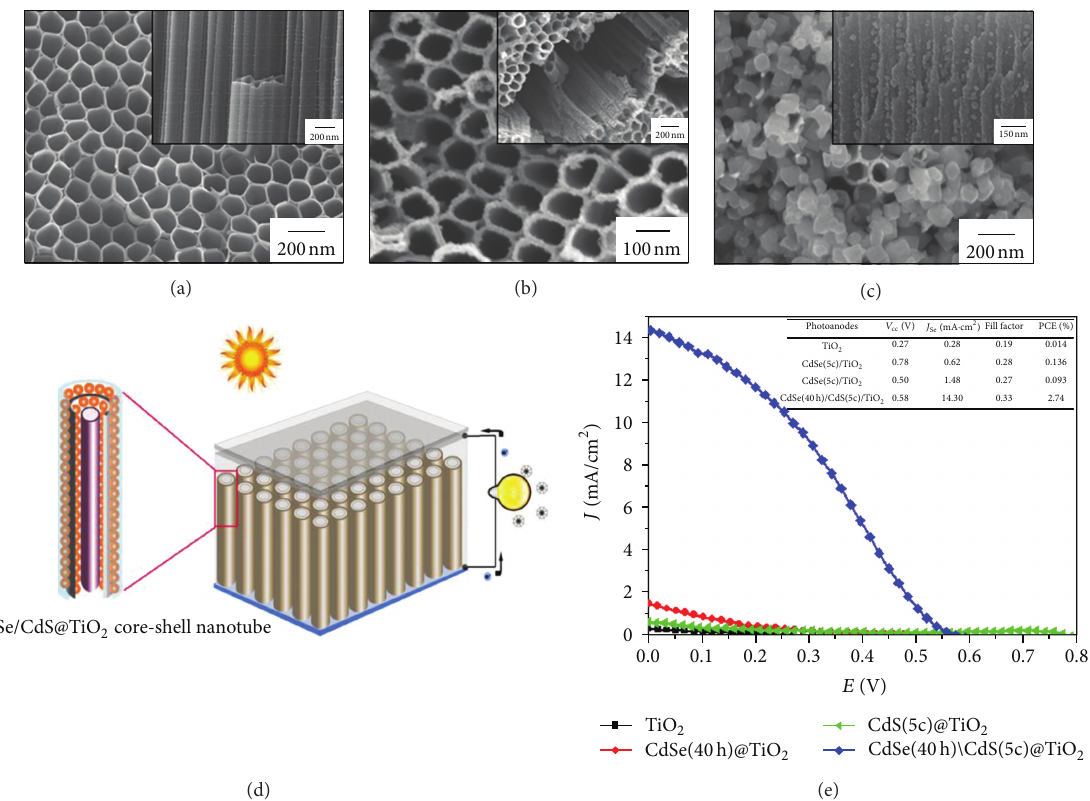
Figure 8: Top view and cross-sectional SEM images of TNAs (a), CdS@TNAs (b), and CdSe/CdS@TNAs (c). (d) Schematic of CdSe/ CdS@TNAs for QDSSC. (e) J-V characteristics of corresponding